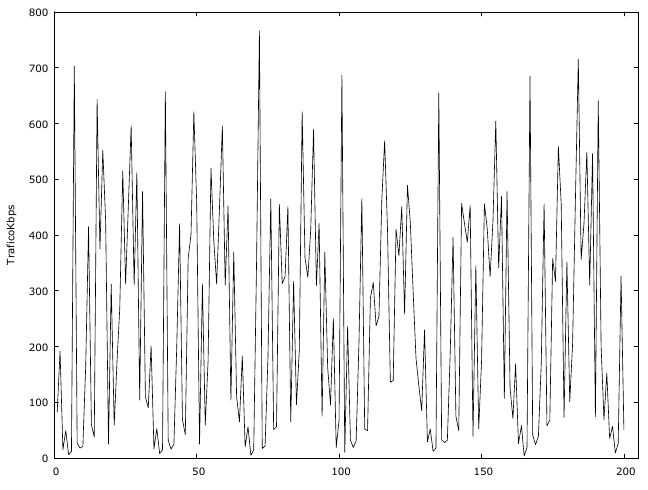
Figure 4. Data tra ffi c measured in kbps for 200 s. Figure 4. Data traffic measured in kbps for 200 s . Figure 4. Data traffic measured in kbps for 200 s .